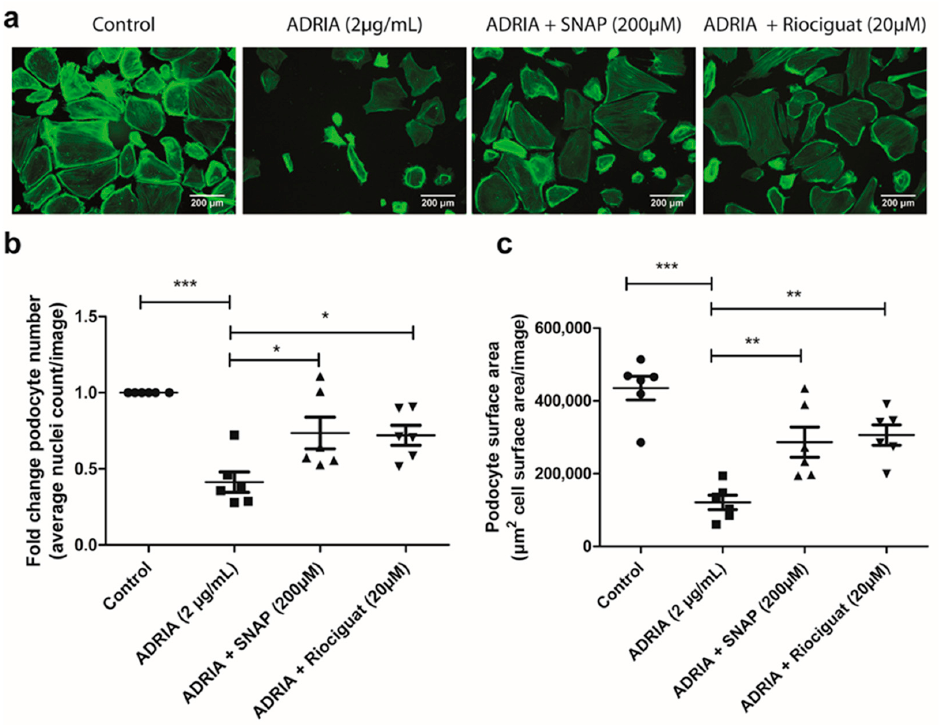
Figure 5. Riociguat and SNAP prevent Adriamycin-induced podocyte injury. hPOD were treated for 24 h with 2 µg/mL Adriamycin to induce podocyte injury. Podocytes were simultaneously treated with either 20 µM Riociguat or 200 µM SNAP. Podocytes were subsequently stained with Phalloidin-FITC and Hoechst 33342. ( a ) Representative pictures are shown for all conditions. Quantitative analyses in FIJI for ( b ) average cell count or ( c ) total cell surface area per image (C) * p < 0.05, ** p < 0.01 *** p < 0.001.